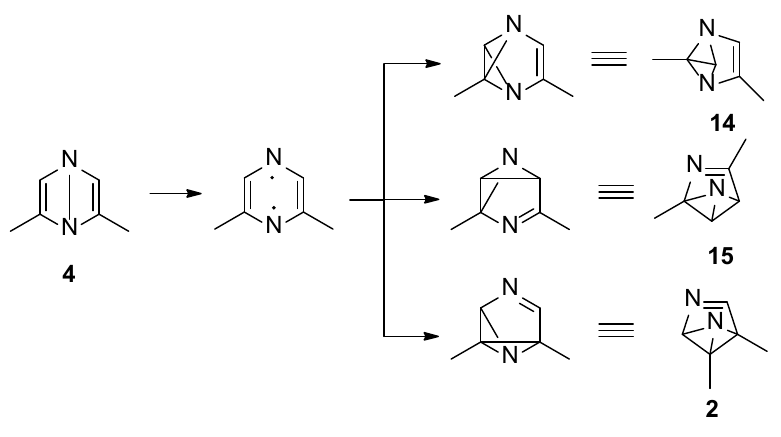
Scheme 3. Benzvalene isomers from 4 .